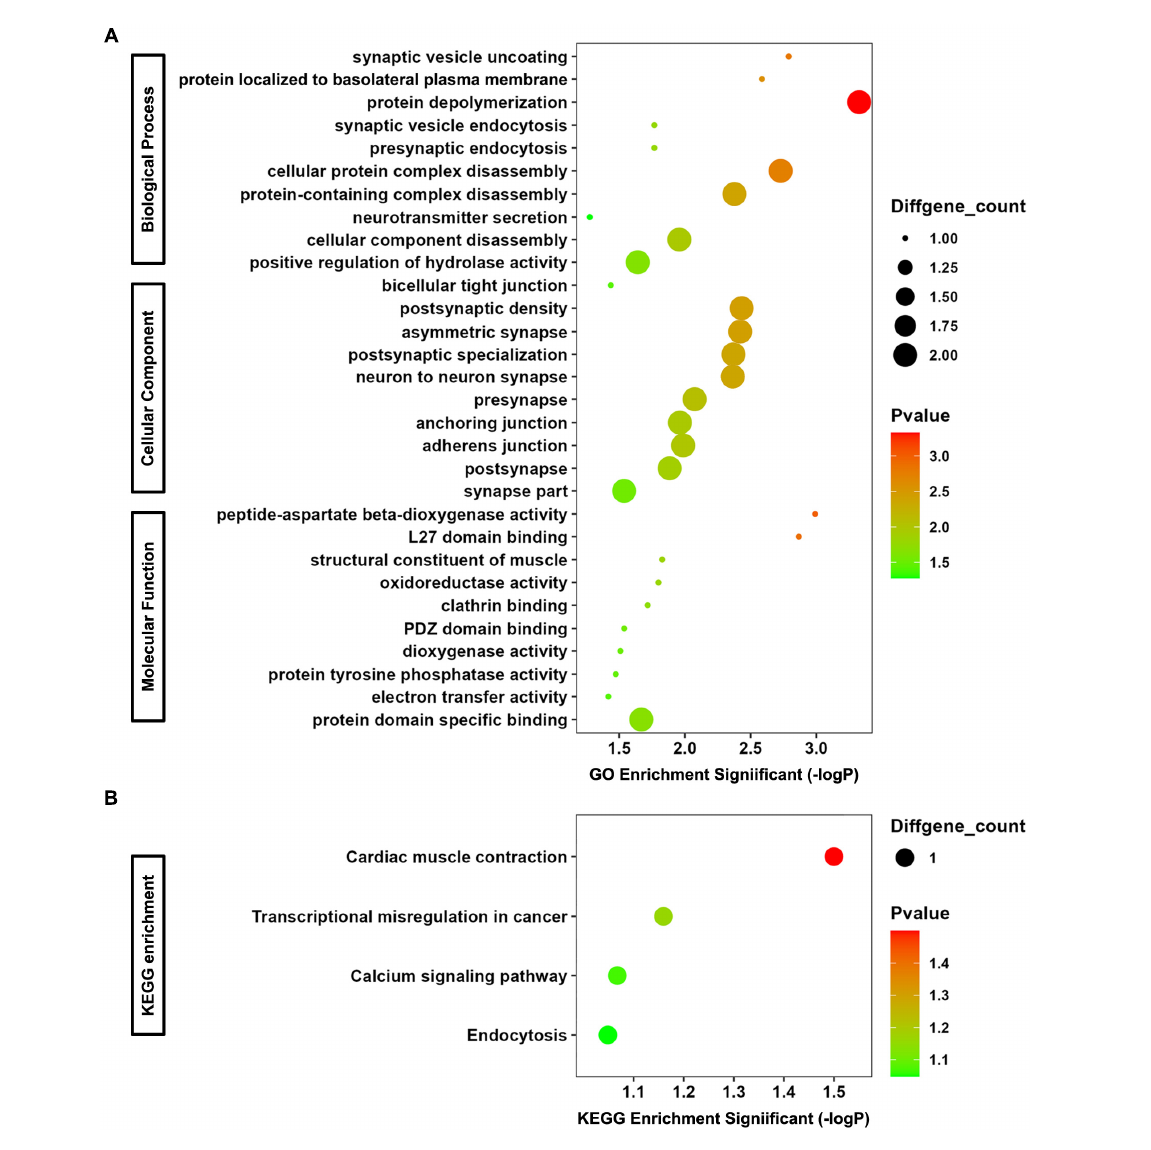
ANXA3, BRK1, CD151, CD9, COL1A1, CYFIP1, SLC44A1, TPM1, and